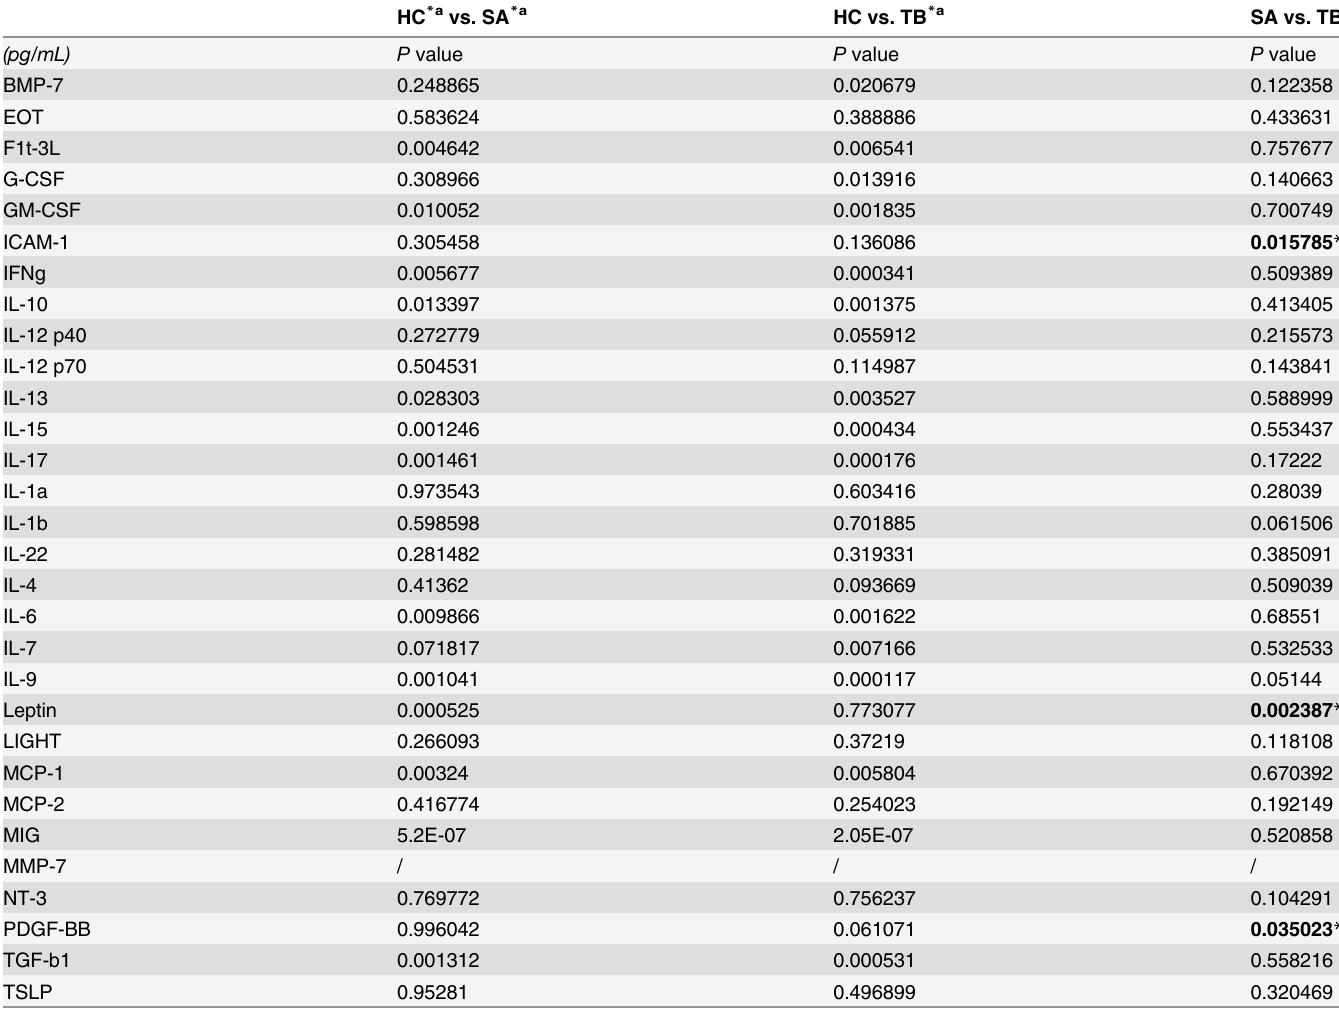
Table 4. Identification of differentially expressed proteins in the SA and TB groups using protein microarray